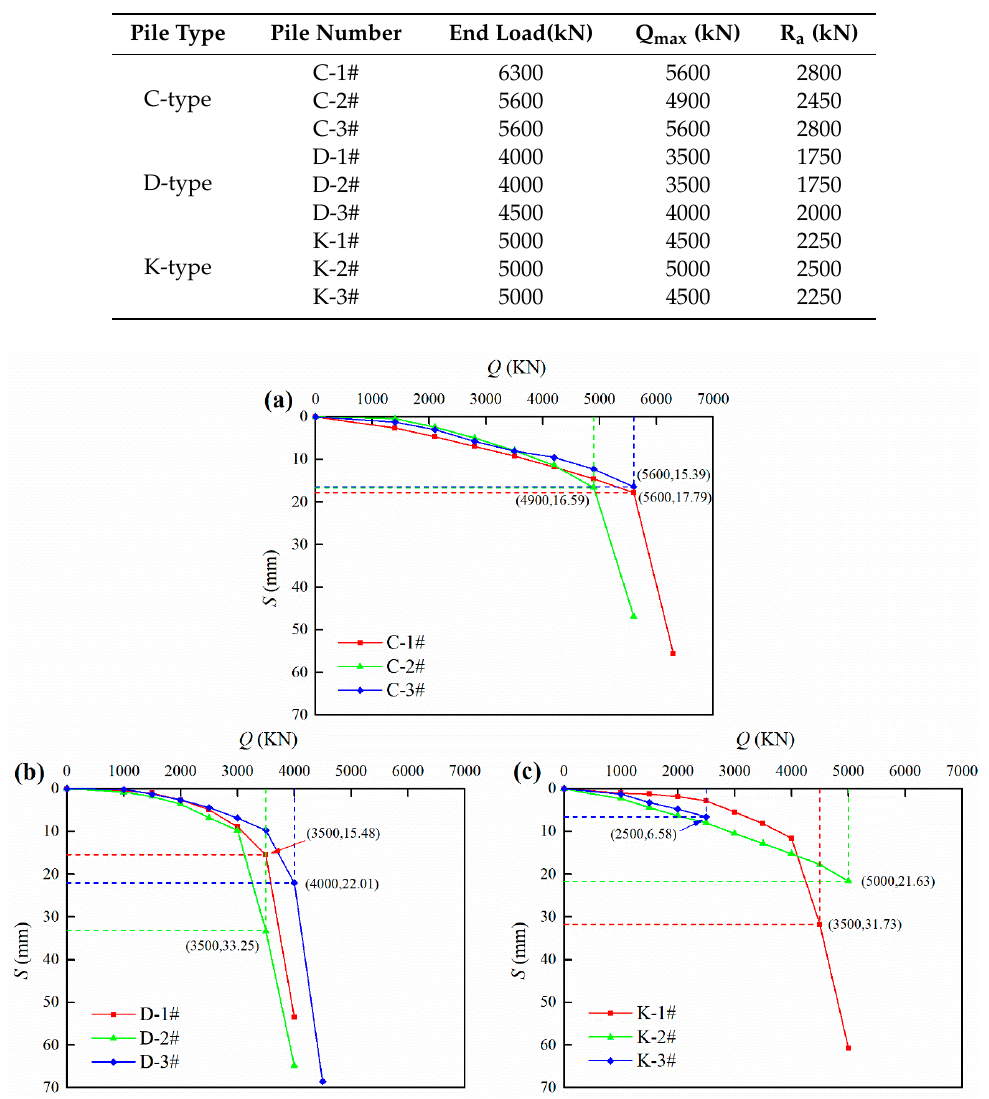
Table 4. Experimental results of di ff erent piles.